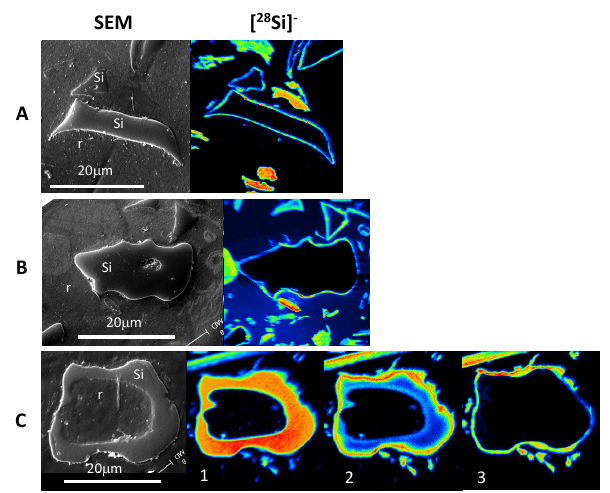
Figure 8. SEM images of the polished section showing convex silica surfaces (Si) in the epoxy resin (r). Associated NanoSIMS [ 28 Si] − images showing central areas devoid of secondary ion signal. (a) [Cs] + primary beam with L1 = 4kV, D 1-1 pri- mary diaphragm (750mm), 11min; (b) [Cs] + primary beam with L1 = 2kV, D 1–2 primary diaphragm (300µm), 11min; (c) [Cs] + primary beam with L1 = 2kV, D1-1 primary diaphragm (750µm), 3min analyses for 1, 2 and 3 successively.